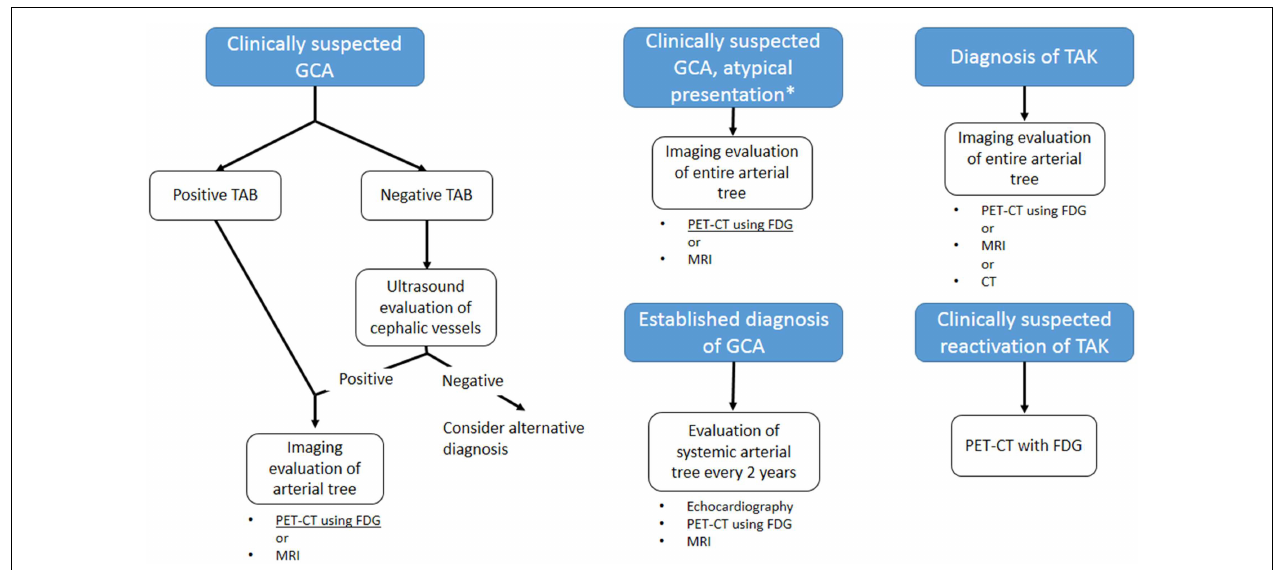
GCA include main large-vessel involvement or fever of unknown origin. MRI is a suitable approach only for the former presentation. Currently, no “gold standard” imaging is defined